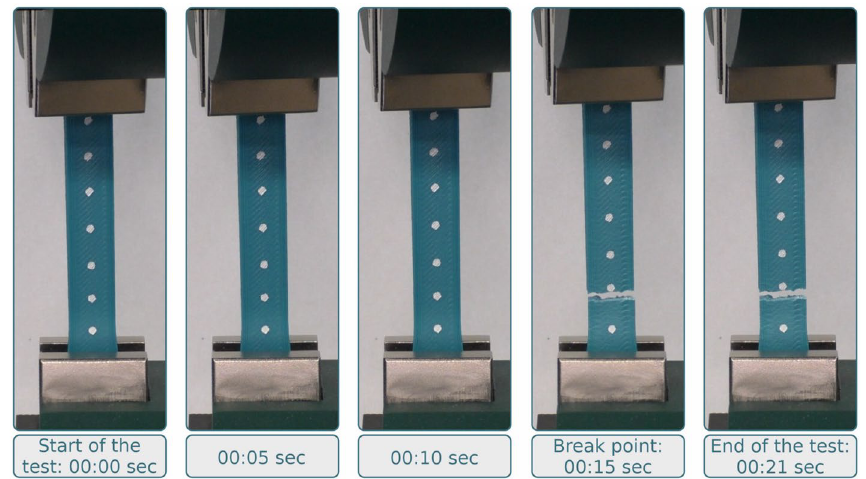
Figure 3. ABS-GF sample under the test conditions. The speed of movement of the upper traverse during the stretching of samples on a universal testing machine was 20 mm/min. The sample width was 13.3 mm, thickness was 3 mm, and estimated length was 80 mm. The width and thickness of the samples are taken from ASTM-D638-14 Type 1.